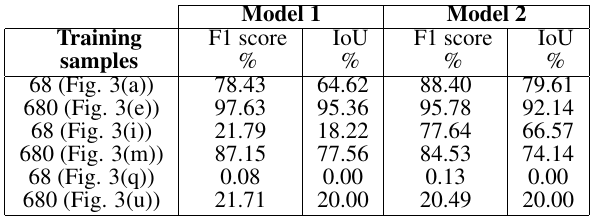
Table 2. Average values of IoU and F1 score for specific samples which are part of 95 test dataset using model 1 and model 2.